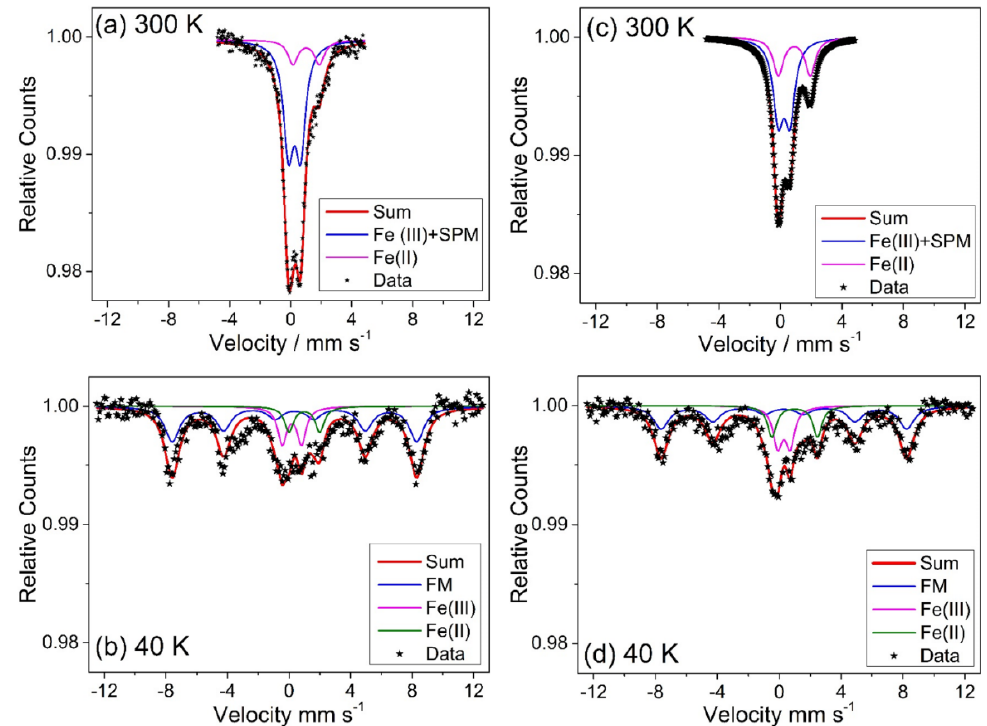
Figure 10. 57 Fe Mössbauer spectra of the Fe substituted γ -Ga 2 O 3 measured at 300 K and 40 K for samples with an Fe:Ga ratio of 1:1 ( a , b ) and a ratio of 3:7 ( c , d ), respectively. SPM indicates superparamagnetic contribution at 300 K.